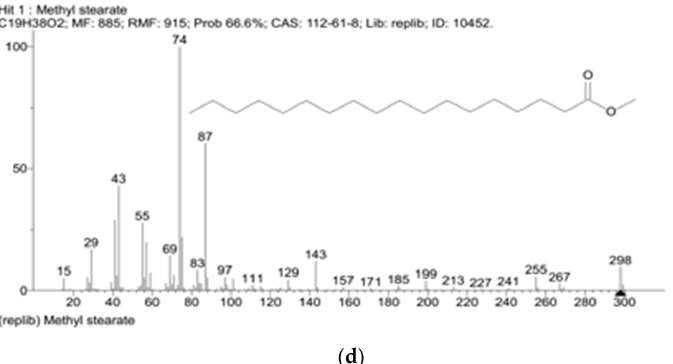
Figure A1. Typical chromatogram ( a ) for FAMES and qualitative GC-MS analysis; ( b ) hexadecenoic acid; ( c ) 9,12-Octadecadienoic acid; ( d ) methyl stearate.